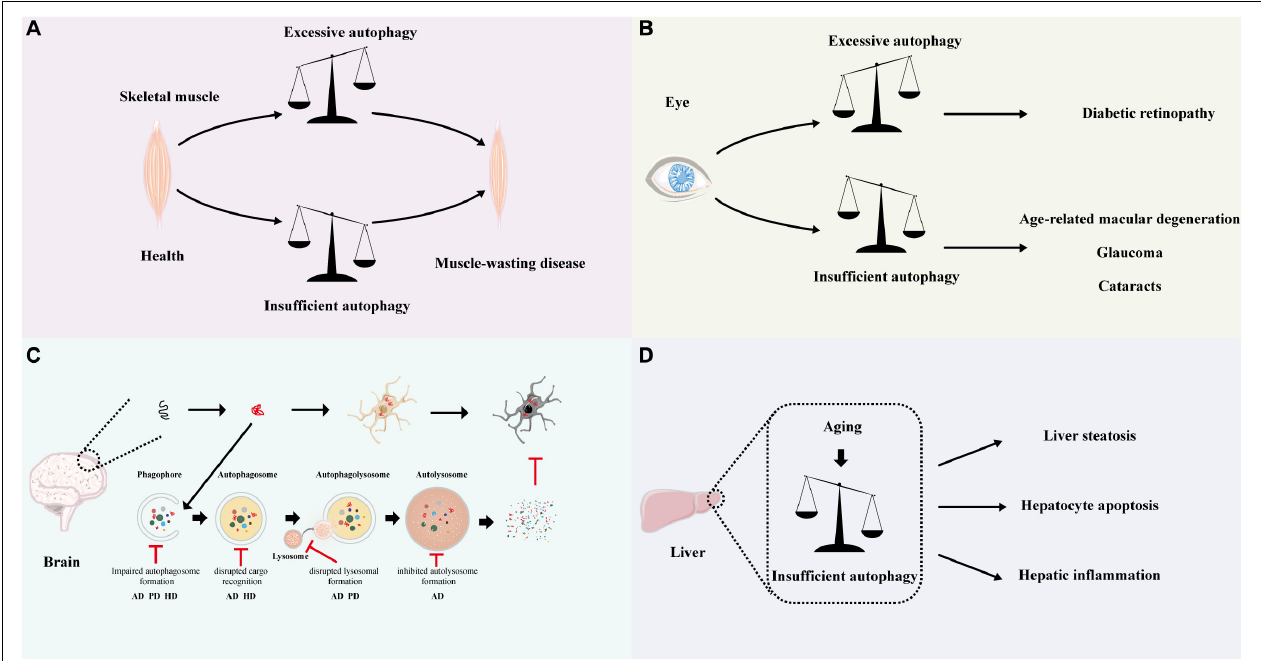
FIGURE 3 | Relationship between autophagy and disease. Schematic depicting the autophagy-related disease in different tissue. (A) In the muscle, both excessive and insufficient autophagy will cause muscle-wasting disease. (B) In the eye, excessive autophagy may lead to diabetic retinopathy, while insufficient autophagy may result in age-related macular degeneration, glaucoma and cataracts. (C) In the brain, the accumulation of misfolded proteins and inclusion bodies is the common pathological hallmark for various neurodegenerative disorders (top). Autophagy may help to eliminate the aggregated proteins and prevent neurodegeneration. Perturbations throughout the autophagic cycle, from autophagosome development to autolysosome formation, have been suggested to cause neurodegenerative disease. The key points in the autophagy pathway along with the associated neurodegenerative diseases are highlighted below. (D) Age-related decline in autophagy may lead to liver steatosis, hepatocyte apoptosis, and hepatic inflammation. AD: Alzheimer’s disease; PD: Parkinson’s disease; HD: Huntington